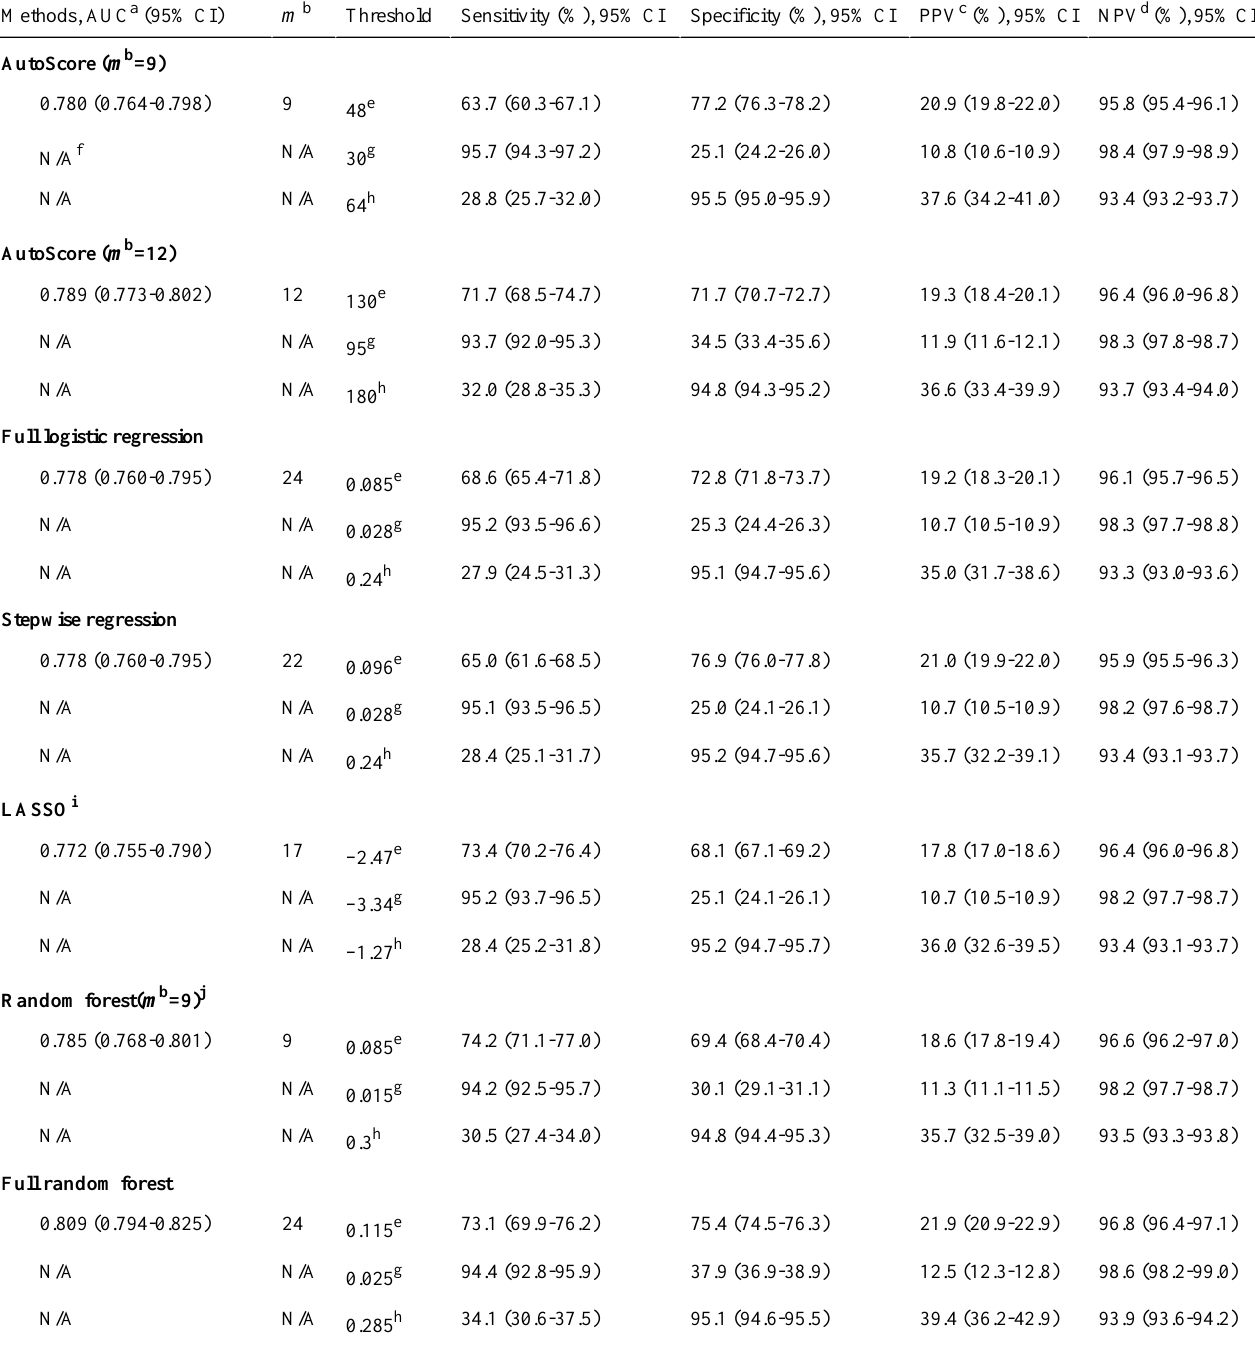
Table 5. Performance of the AutoScore and other baseline